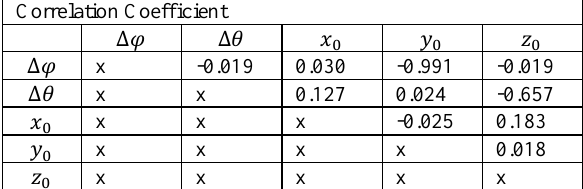
Table 3. Correlation coefficient of estimated parameters of